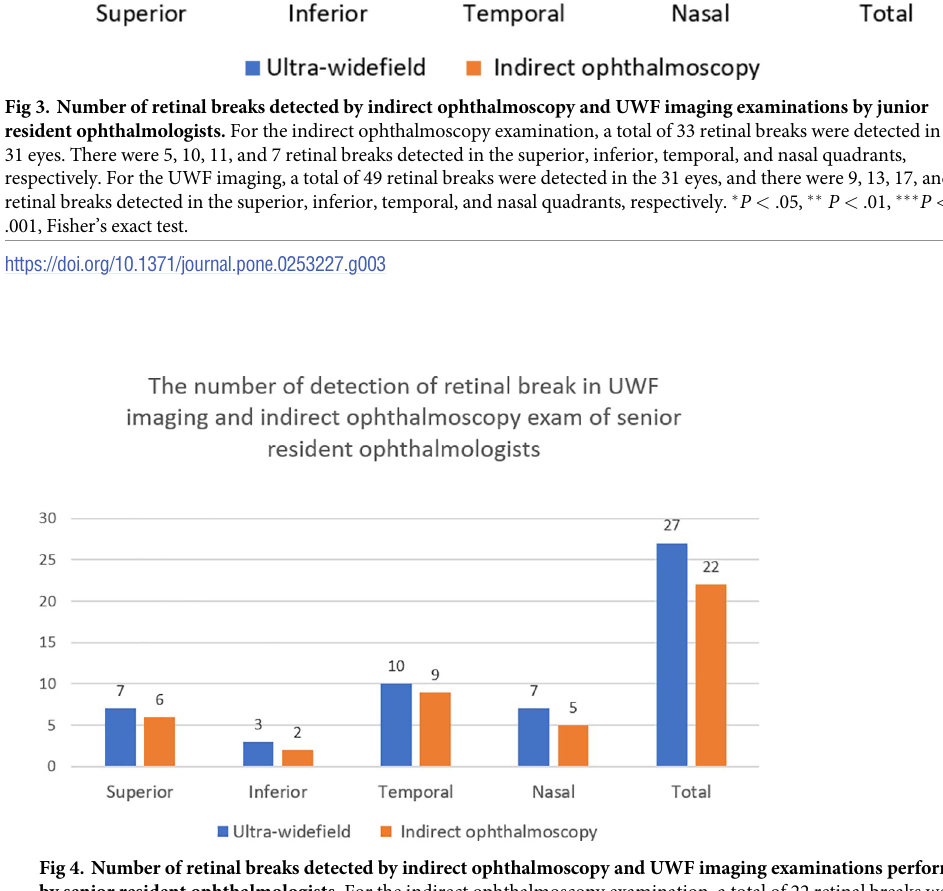
PLOS ONE | https://doi.org/10.1371/journal.pone.0253227 June 23,